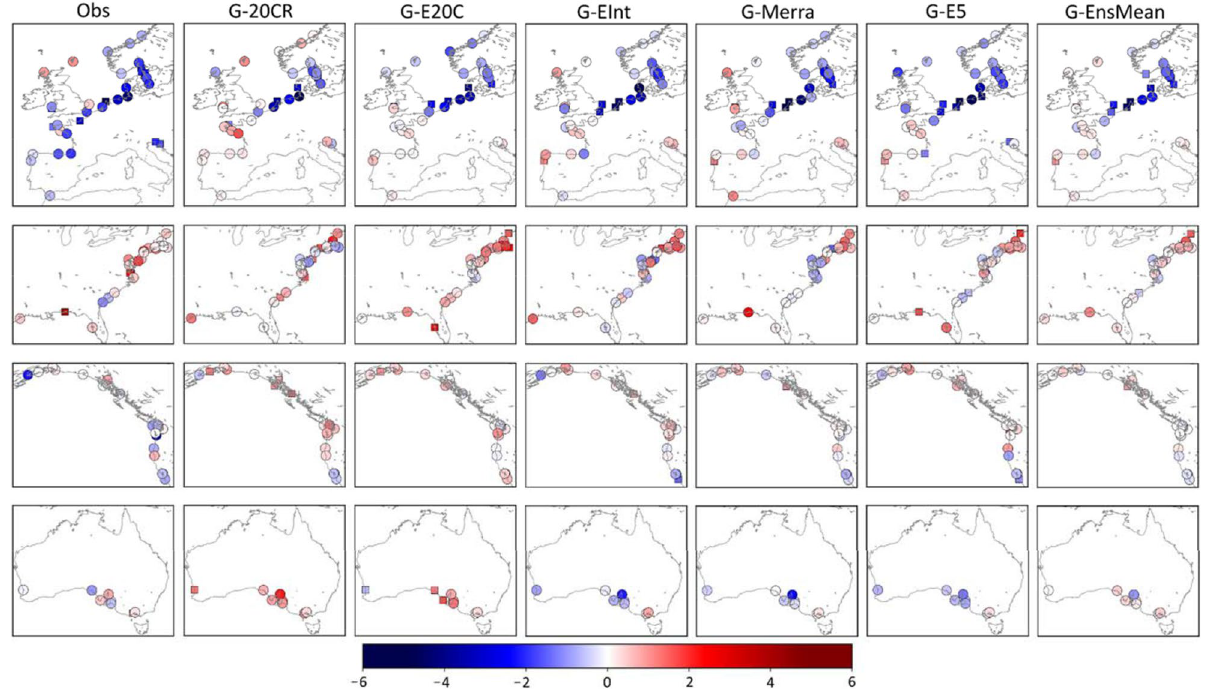
Figure 9. Trends (mm/year) for the 1980–2010 period for all seven datasets (including ensemble mean); significance is assessed at 5% level and significant trends are shown as rectangles. Rossum, Guido van, et al., The Python Language Reference, Python Software Foundation; http:// docs. python. org/ py3k/ refer ence/ index. html.